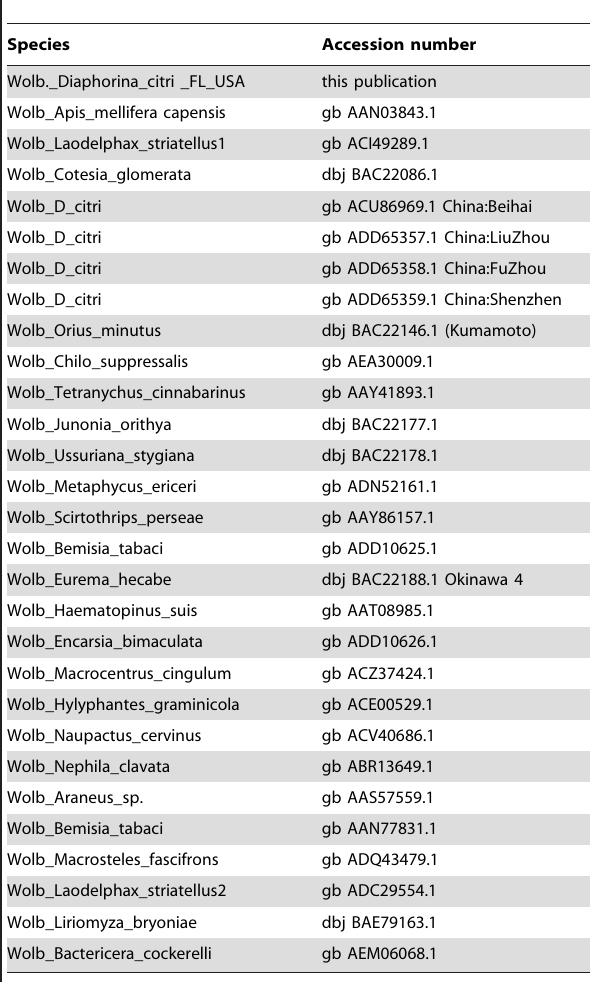
Table 4. Wolbachia wsp gene sequence accession numbers used in phylogenetic